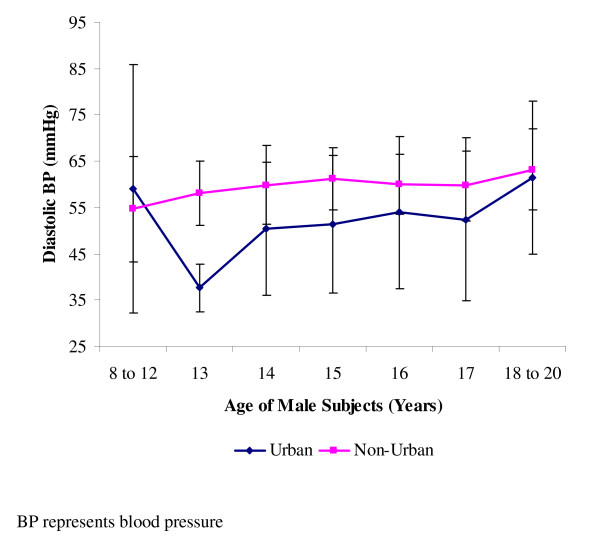
Mean diastolic blood pressures of male subjects. Data (mean ± standard deviation) are for diastolic blood pressures of 615 males studied, and made up of 185 urban dwellers and 430 non-urban dwellers.